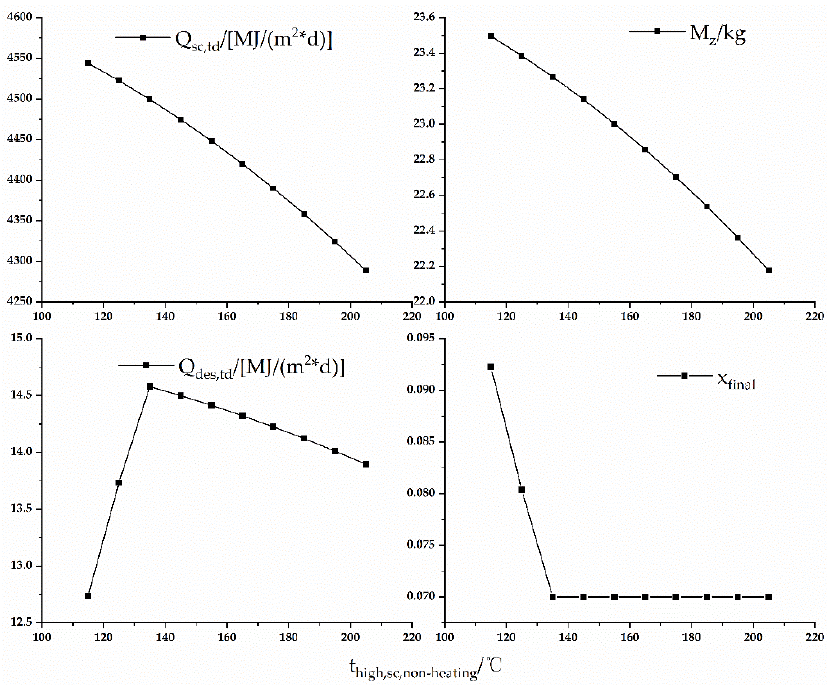
Figure 13. Variations in the key parameters with the high temperature of solar collection in the non-heating season.